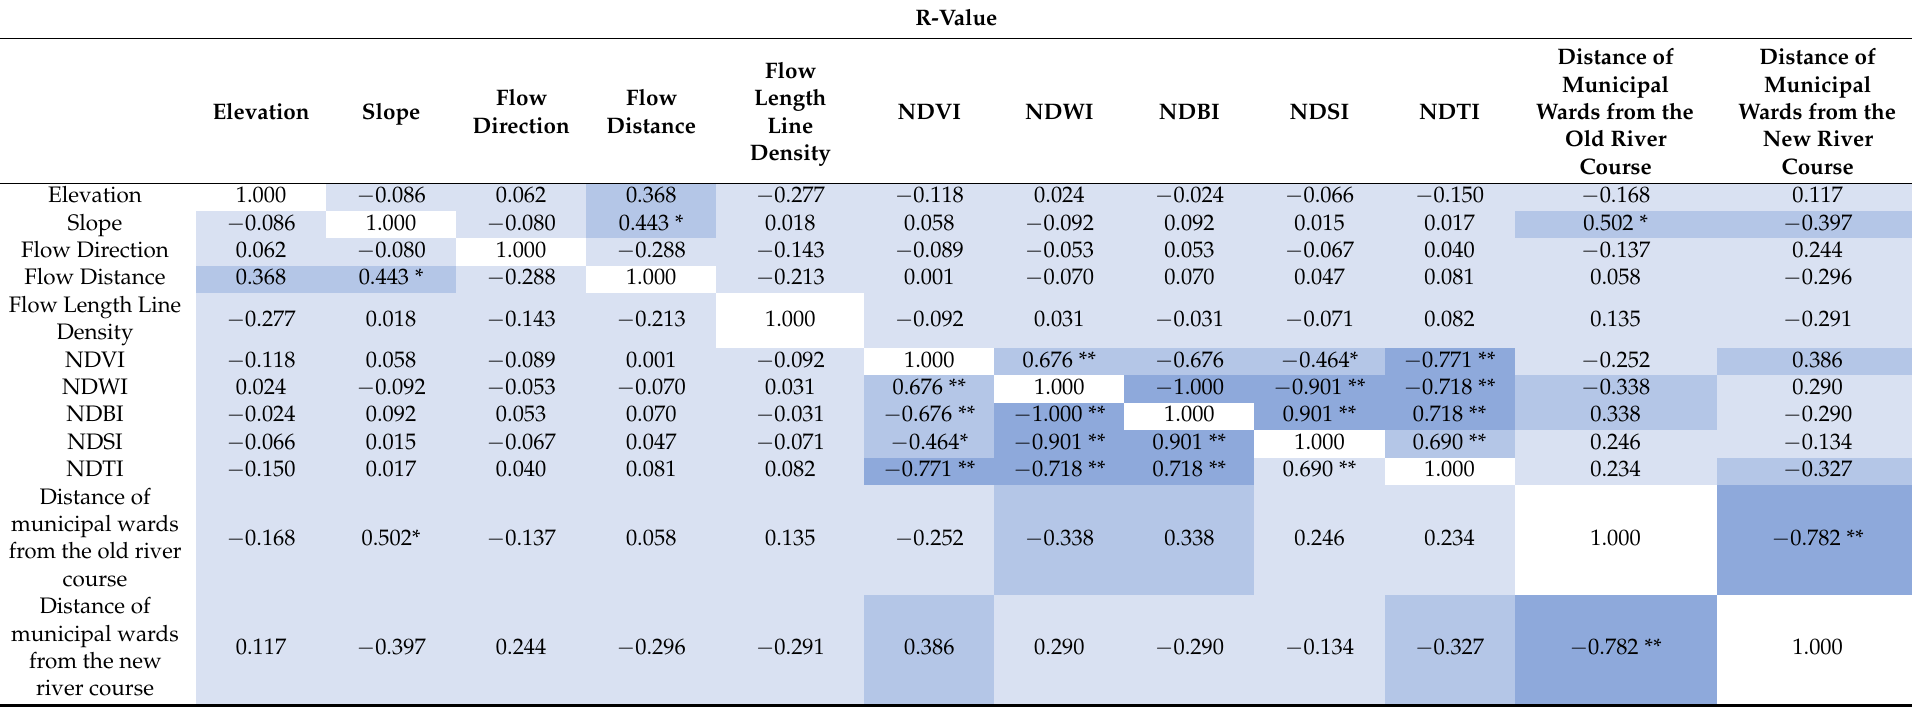
Table 6. Correlation matrix of the selected indicators of flood vulnerability (2000).